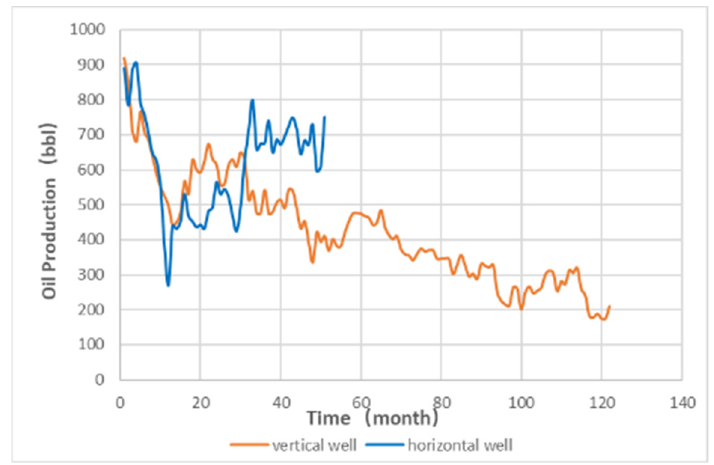
Figure 2. Comparison figure of average daily oil production between vertical wells and horizontal wells in A reservoir.